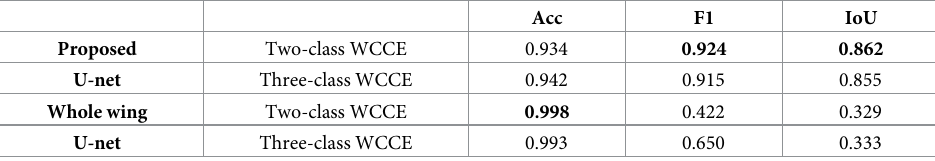
eyespots in dataset2, which were placed at the corresponding eyespots position on the wing. To train this U-net we resized the images and corresponding GT masks to 640x640. For larger image sizes, training of the U-net model did not converge and for smaller sizes the eyespot areas were too small to segment. After segmentation, we used connected components labelling to identify the different eyespots. There was no need for further post-processing to separate the eyespots, watershed for example, since there is no overlap between them. Training used the same weighted loss function and optimizer as our U-net. The class weights for eyespot rings the image pixels are now background. For the two-class data the weights were 50 for the eye- spot rings and 1 for the rest of the image area, and for the three-class data they were 600, 25, and 1, corresponding to the eyespot rings, center, and background, respectively. Table 5 pres- ents the accuracy, F1 and IoU results of both U-Net segmentation models with two-class data and with three-class data.